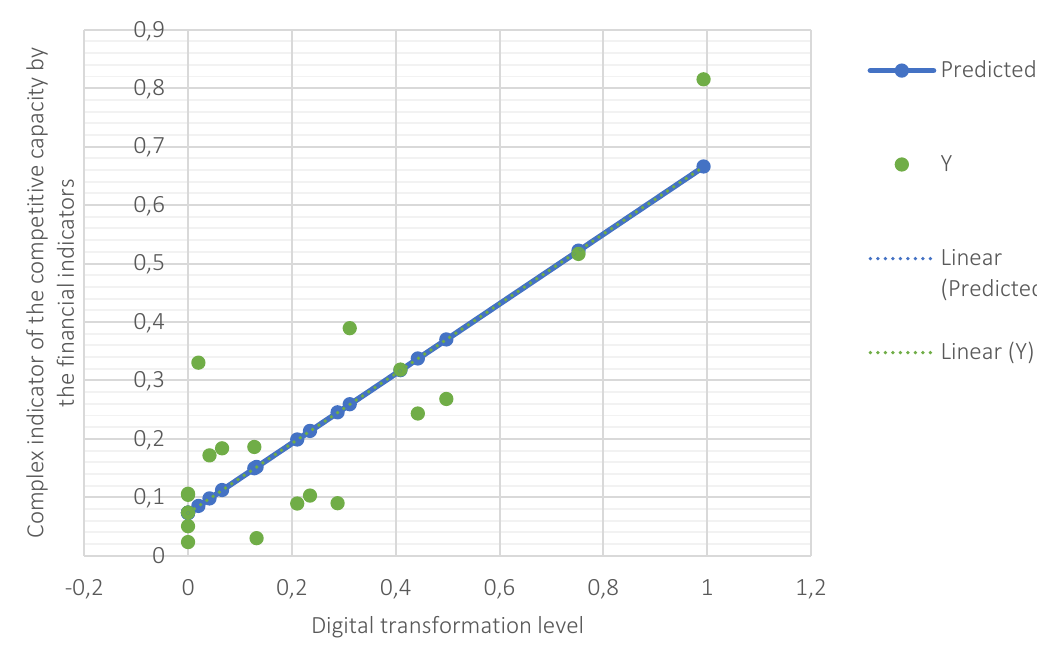
Digital transformation Figure 3. Dependence of the competitive capacity of banks on the digital transformation level